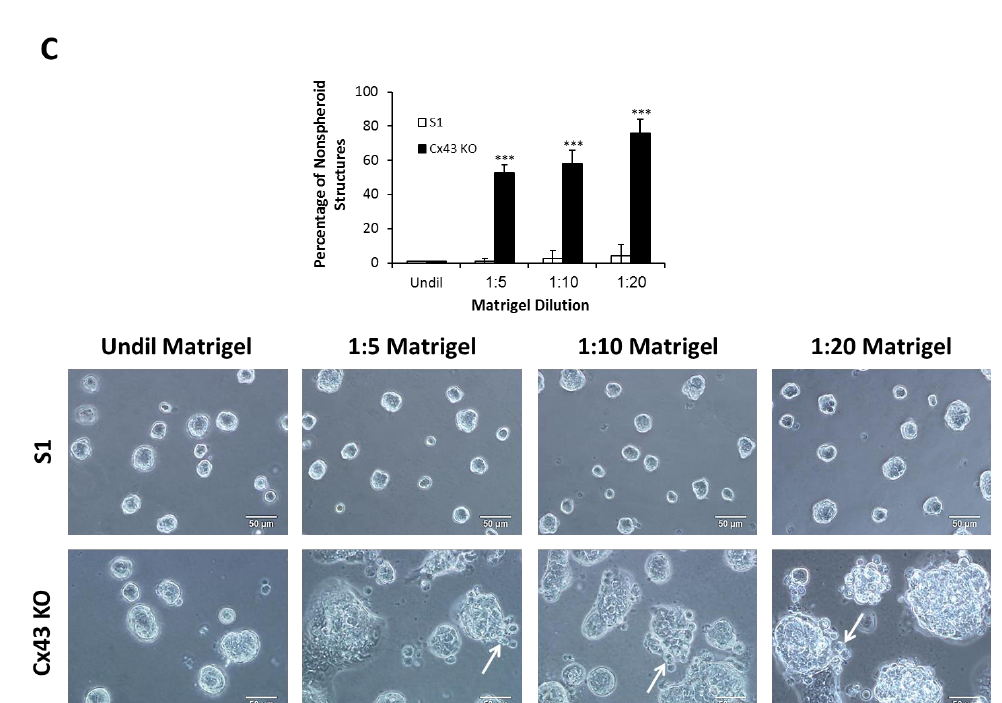
Figure 6. Silencing Cx43 induces motility and invasion in S1 cells. A. S1 and Cx43-shRNA S1 cells (Cx43 KO) were cultured under 2-D conditions. Motility was assessed by time-lapse imaging on day 5. The total paths of representative S1 and Cx43 KO cells from time-lapse movies (upper panel) are shown (different colors represent different cells). Histograms show the quantification of cell motility. A total of 50 cells were analyzed per group. The values depicted are the means (± S.D.) of total path lengths (left lower panel) or migration speeds (right lower panel) from two independent experiments. Unpaired t-test; **p < 0.01. B. Invasion of S1 and Cx43 KO cells across diluted Matrigel (1:5) was assessed by transwell cell invasion assay (upper panel). The values depicted in the histogram are the means (± S.D.) of fold change in number of Matrigel-invading cells from three independent experiments. Unpaired t-test; **p < 0.01. Representative images of cells cultured under 2-D conditions and stained for F-actin on day 5 (lower panel) are shown. Arrows indicate invadopodia-like actin-rich dots. C. S1 and Cx43 KO cells were cultured under 3-D conditions atop of different Matrigel dilutions (undiluted, 1:5, 1:10 and 1:20 dilutions). Invasion was assessed by counting nonspheroid structures on day 11. One hundred structures were analyzed per group. The values depicted in the histogram (upper panel) are the means (± S.D.) of nonspheroid structures from three independent experiments. Unpaired t-test; ***p < 0.001. Representative images of cells (lower panel) are shown. Arrows indicate migrating Cx43 KO cells. Undil; Undiluted.